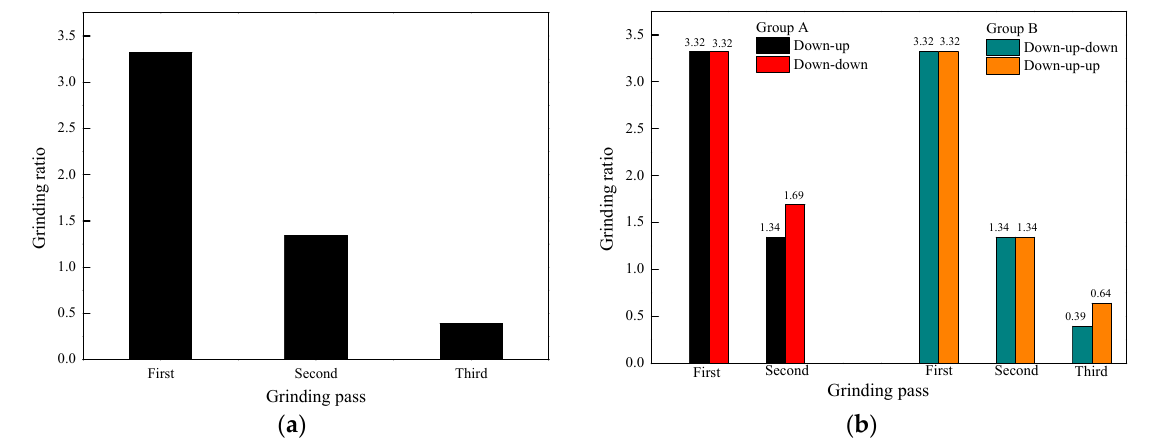
Figure 9. Change in the grinding ratio with ( a ) the number of grinding passes and ( b ) a change in the grinding direction. grinding